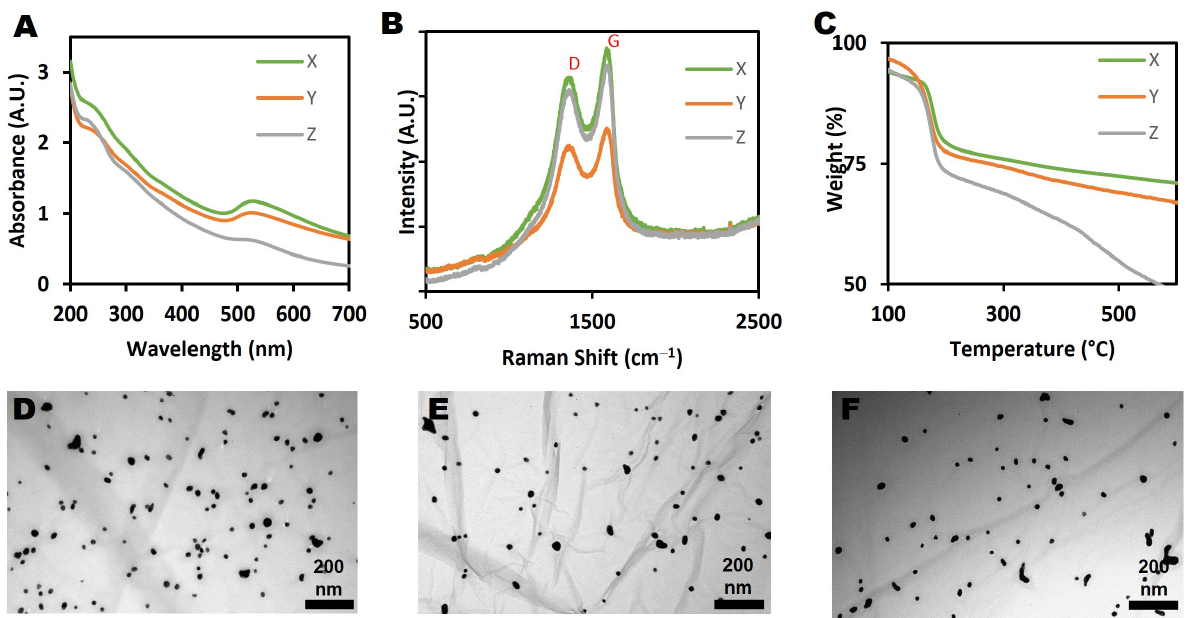
Figure 2. Characterization of three batches of GO ‐ Au nanohybrid (X, Y & Z): ( A ) UV ‐ vis absorption spectrum, ( B ) Raman spectrum, ( C ) thermogravimetric analysis spectrum, ( D – F ) TEM images corresponding to each of the 3 replicate nanohybrids. Table 2. Analysis of C1s scan showing the chemical groups in GO ‐ Au. Functional Groups